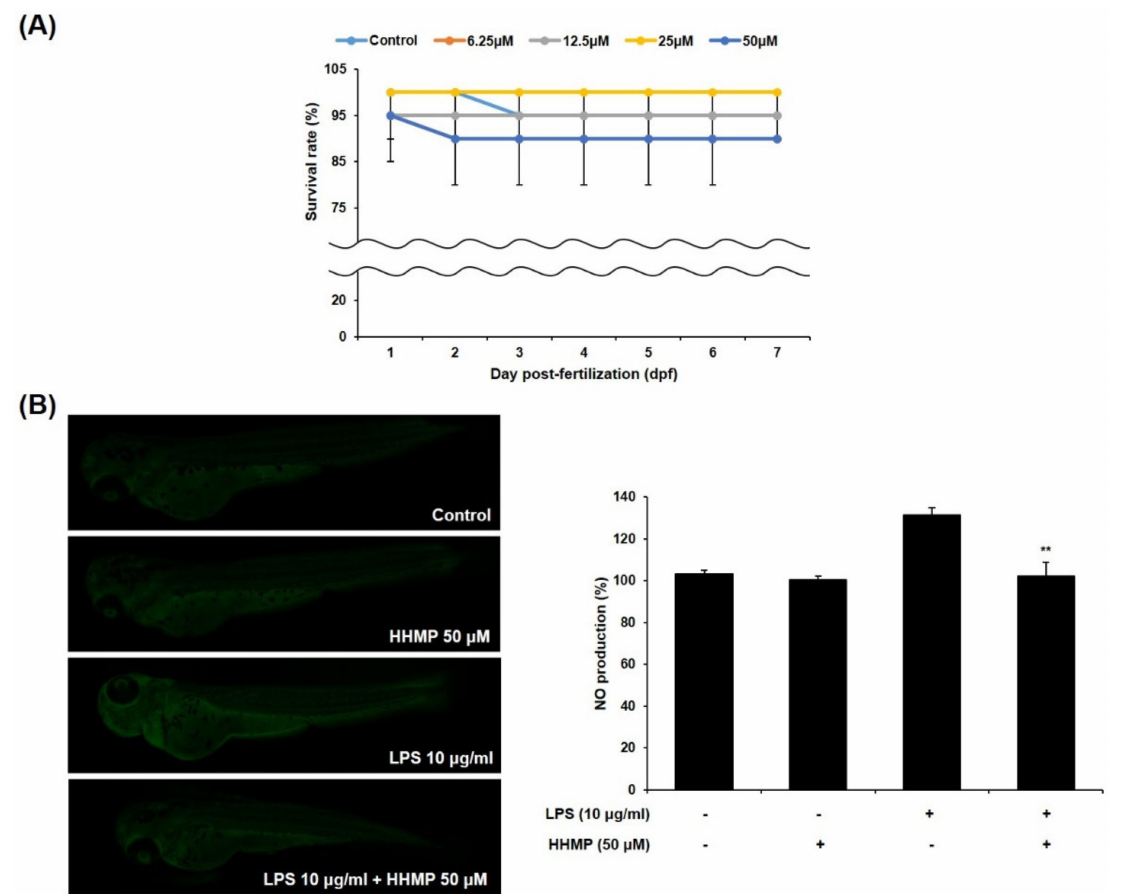
Figure 5. Effect of HHMP on ( A ) survival rate and ( B ) NO production in zebrafish larvae. Survival rate of zebrafish larvae was measured for 7 dpf after treatment with HHMP (6.25, 12.5, 25, and 50 µ M). NO production of zebrafish larvae was assessed using an LSM 700 Zeiss confocal laser scanning microscope after treatment with 50 µ M of HHMP in presence or absence of LPS for 72 hpf. Fluorescence intensity was quantified using ImageJ software. +: added in the cells; -: not added in the cells. All experiments were performed in triplicate, and the results are expressed as the mean ± standard deviation (SD); * p < 0.05, ** p < 0.01, *** p < 0.001, and **** p < 0.0001 compared with the LPS-stimulated